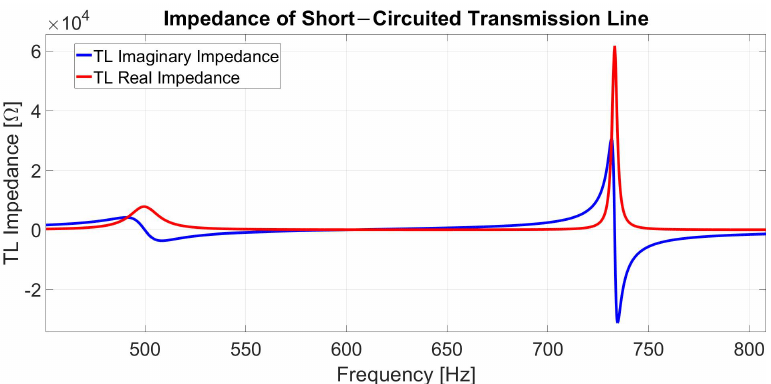
Figure 7. Frequency response measurements of transmission line